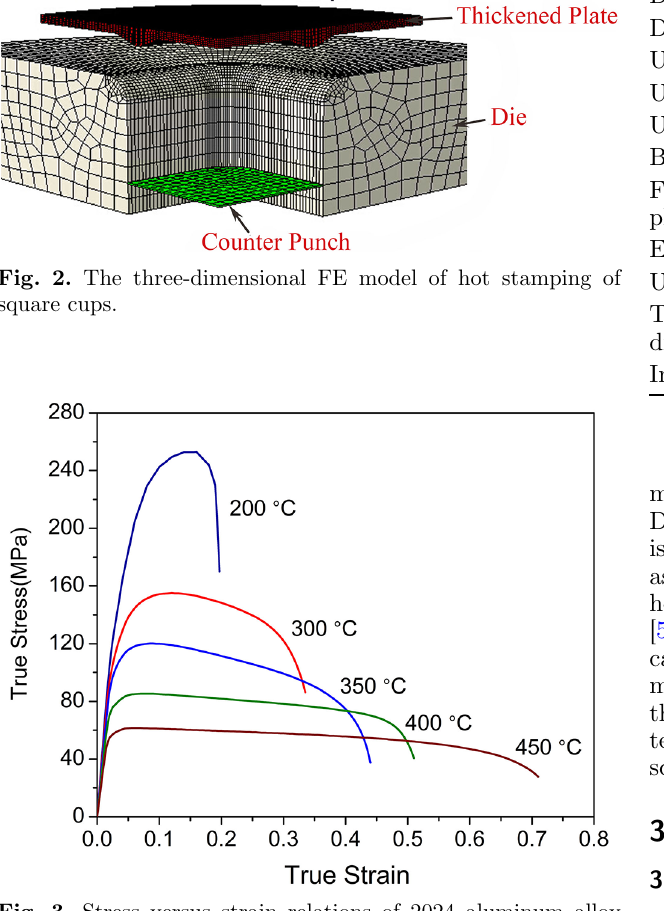
Fig. 3. Stress versus strain relations of 2024 aluminum alloy (strain rate is 0.1/s).